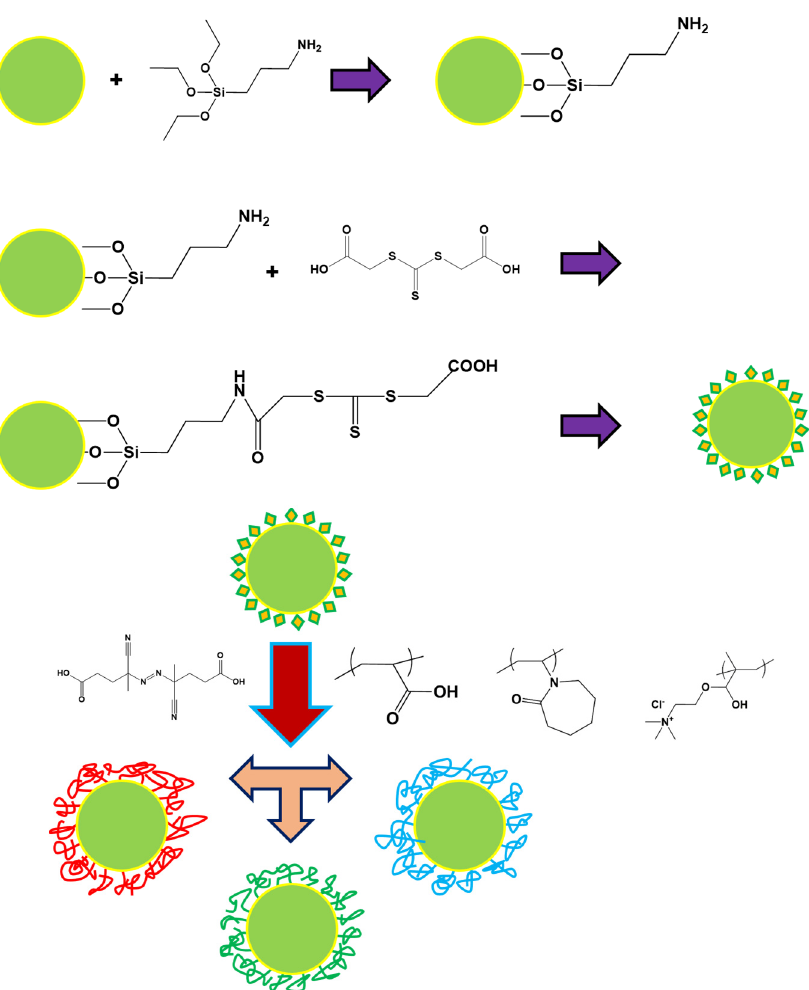
Figure 1. Anchoring CTA to CeO 2 particles and polymerization via RAFT for the preparation of polymer brushes from the surface.